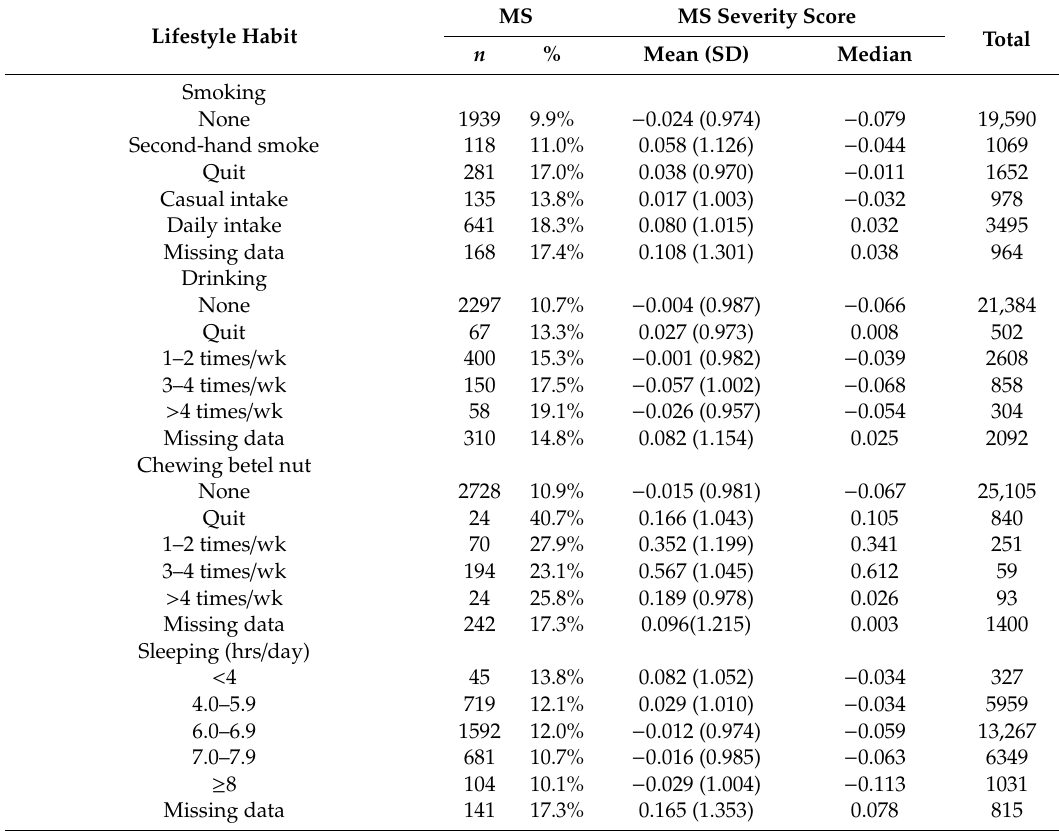
Table 4. MS prevalence and severity scores categorized according to lifestyle